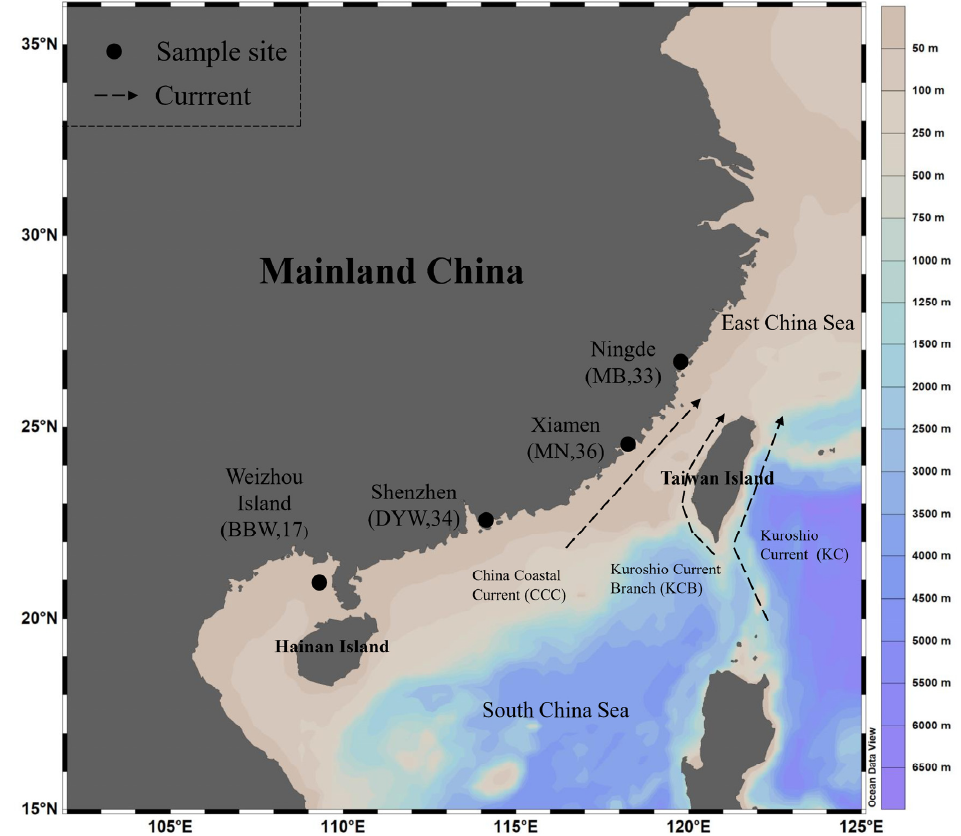
Figure 1. Map of the southern coast of mainland China illustrating the sampling locations of Epinephelus awoara . KC: Kuroshio Current; KCB: Kuroshio Current Branch; CCC: China Coastal Current. Sampling site: Ningde, Xiamen, Shenzhen, Weizhou Island. Geographic population code: MB,